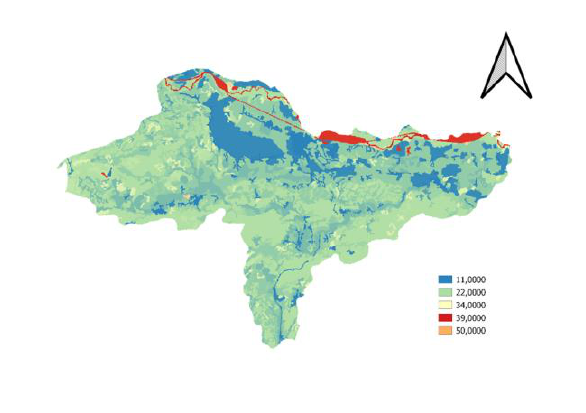
Figure 7 . Land cover for Varaždinska county Agricultural areas (values 12-22) and certain values of forests and semi-natural areas (values 26-32) such as natural grasslands, dunes, bare rocks, sparsely vegetated areas are suitable for placing panels on free areas (Figure 8). Based on CORINE land cover suitable areas were selected. White areas are suitable for building panels, and black ones are not.